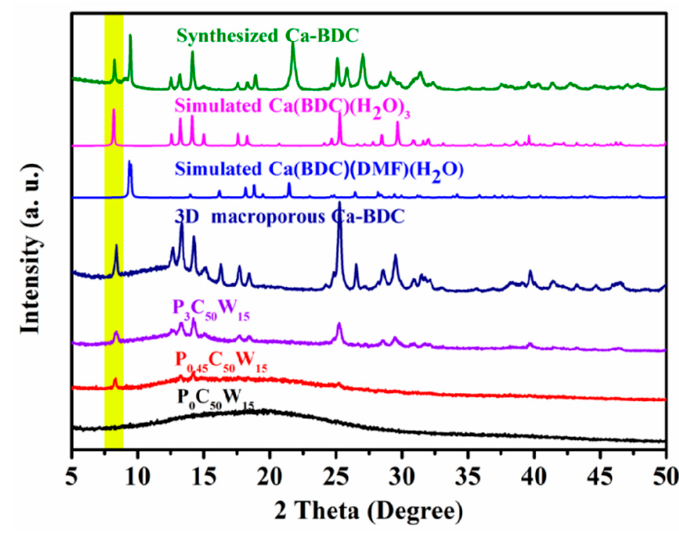
Figure 9. The XRD patterns of polyHIPEs P x C 50 W 15 templated from C/W HIPEs containing 0, 0.45, and 3 g Ca-BDC, respectively, and 3D macroporous Ca-BDC.